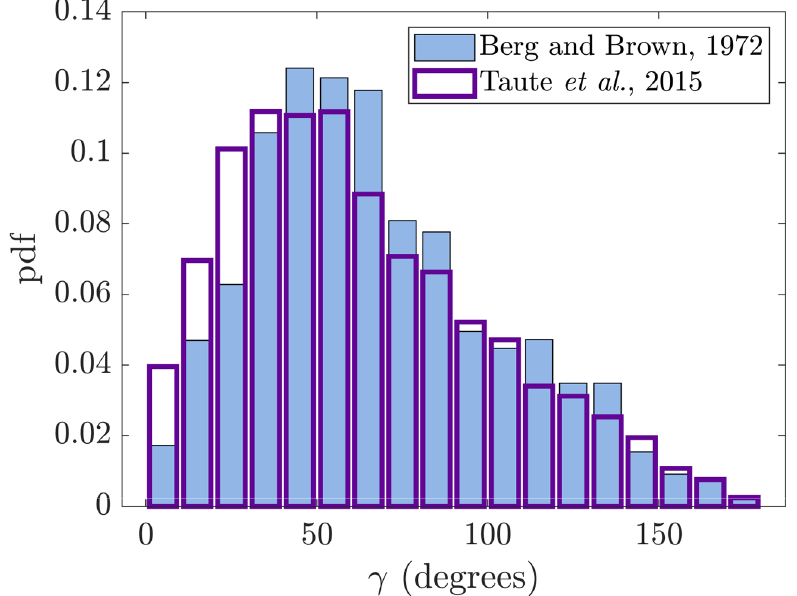
Fig 1. Experimental probability density function (pdf) for the angle γ (in degrees) measuring the change in direction from the end of one run to the beginning of the next for wild type E. coli cells, reproduced from Berg and Brown [38] (blue) and Taute et al . [42] (hollow with purple